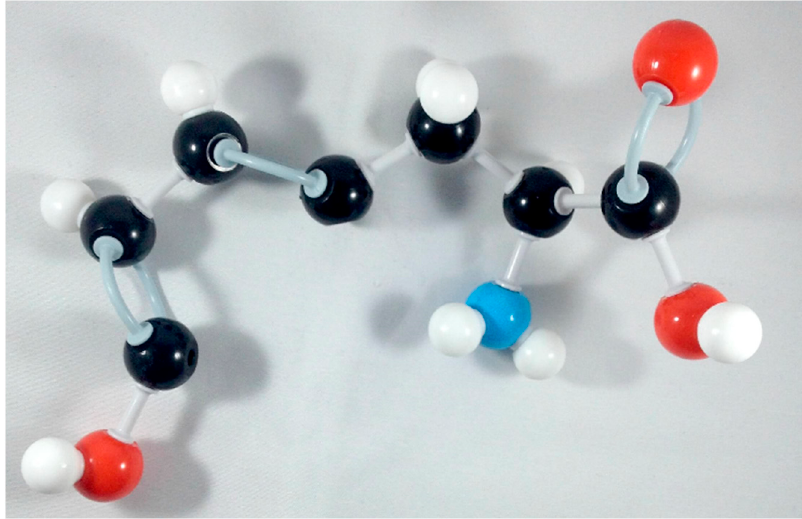
Figure 1. Physical 3D educational modalities for medicinal chemistry courses.